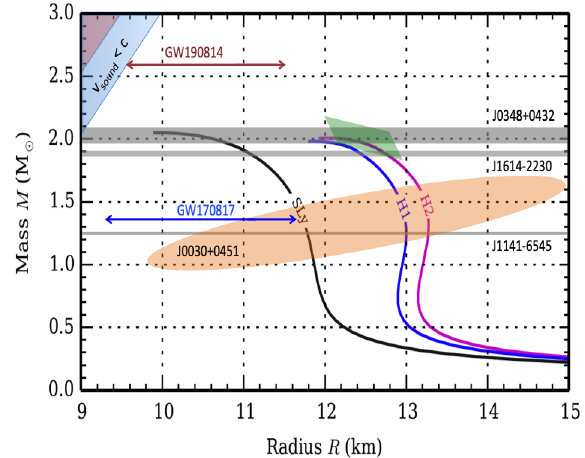
Figure 4: (Color online). The mass-radius relation for neu- tron matter including hyperons (H1 and H2) for K 0 = 245 and 260 MeV respectively. The green area shows the un- certainty on the mass and radius of stars with hyperons in the core due to the fact that the properties of these parti- cles are barely constrained by laboratory